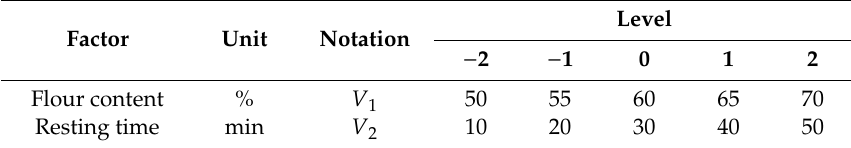
Table 2. Factors and levels used for stickiness and moisture content